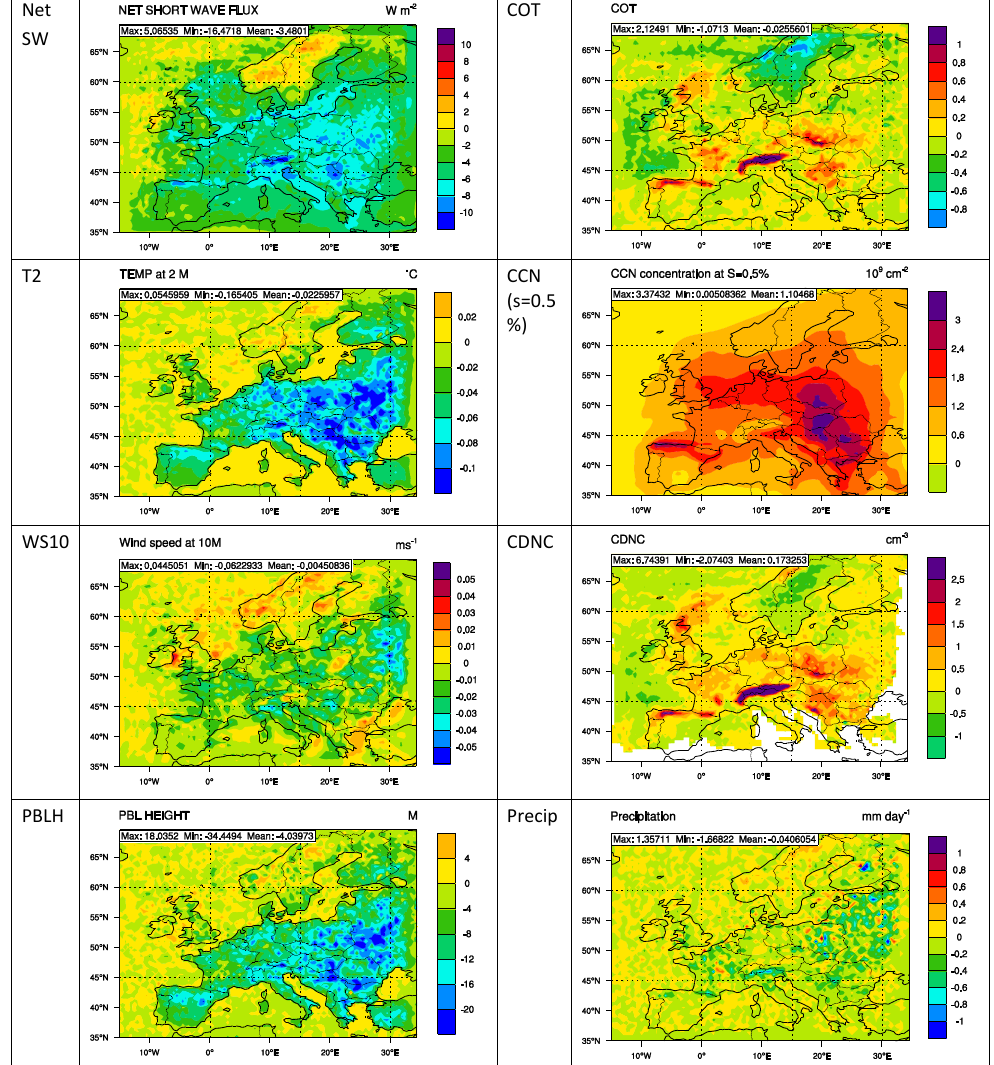
Figure 5. Simulated changes in meteorological variables due to the direct, semi-direct, and indirect effects of aerosols by WRF/Chem-MADRID in July 2001 over D01.